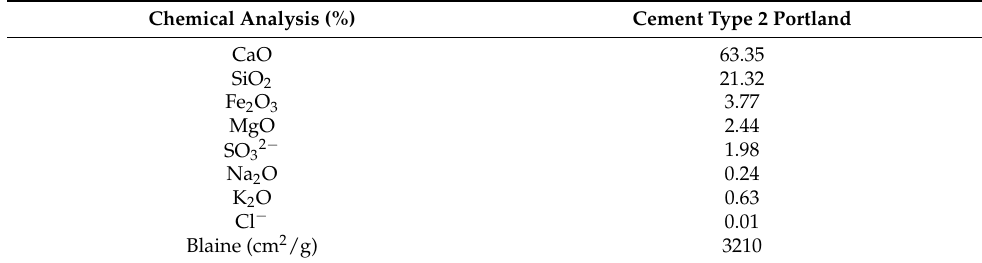
Table 1. Chemical composition and properties of cement type 2.